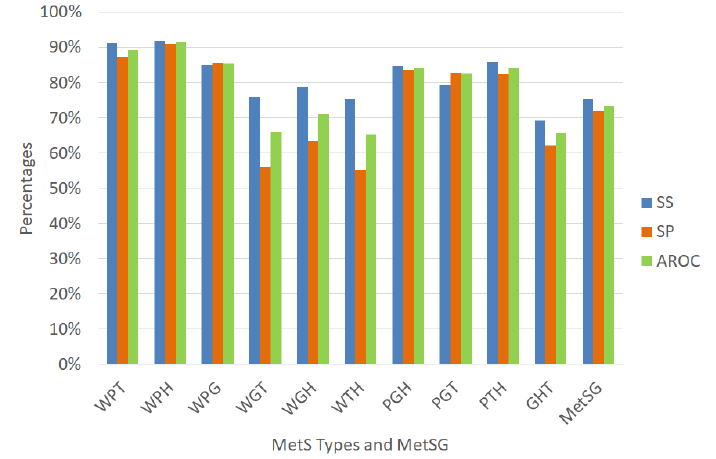
Figure 12. Performance indicators of the RusBoost for the MetS types using the dataset with